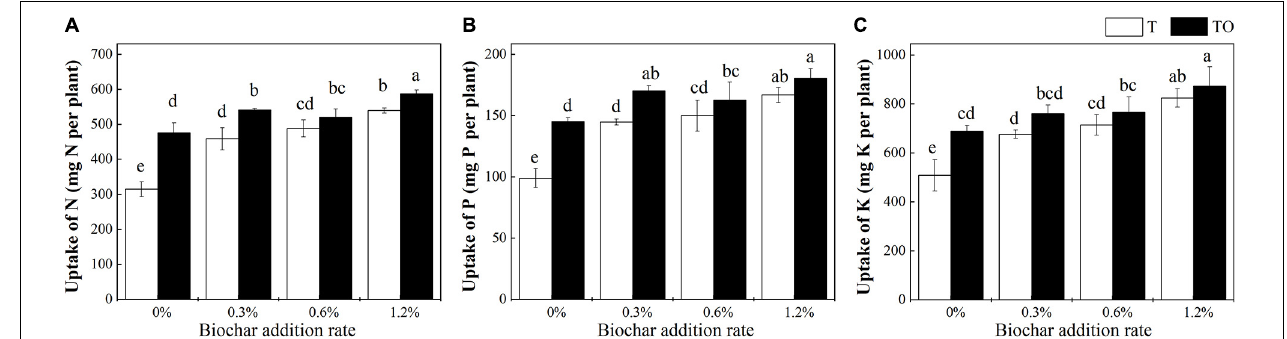
FIGURE 2 | Effects of biochar and intercropping on uptake of N (A) , P (B) , and K (C) of tomato plant after 30 days pot experiment in 2019. T and TO indicate tomato monoculture and intercropped with potato–onion, respectively. 0, 0.3, 0.6, and 1.2% indicate the biochar rates. Different letters indicate the statistically significant differences among treatments ( P < 0.05).